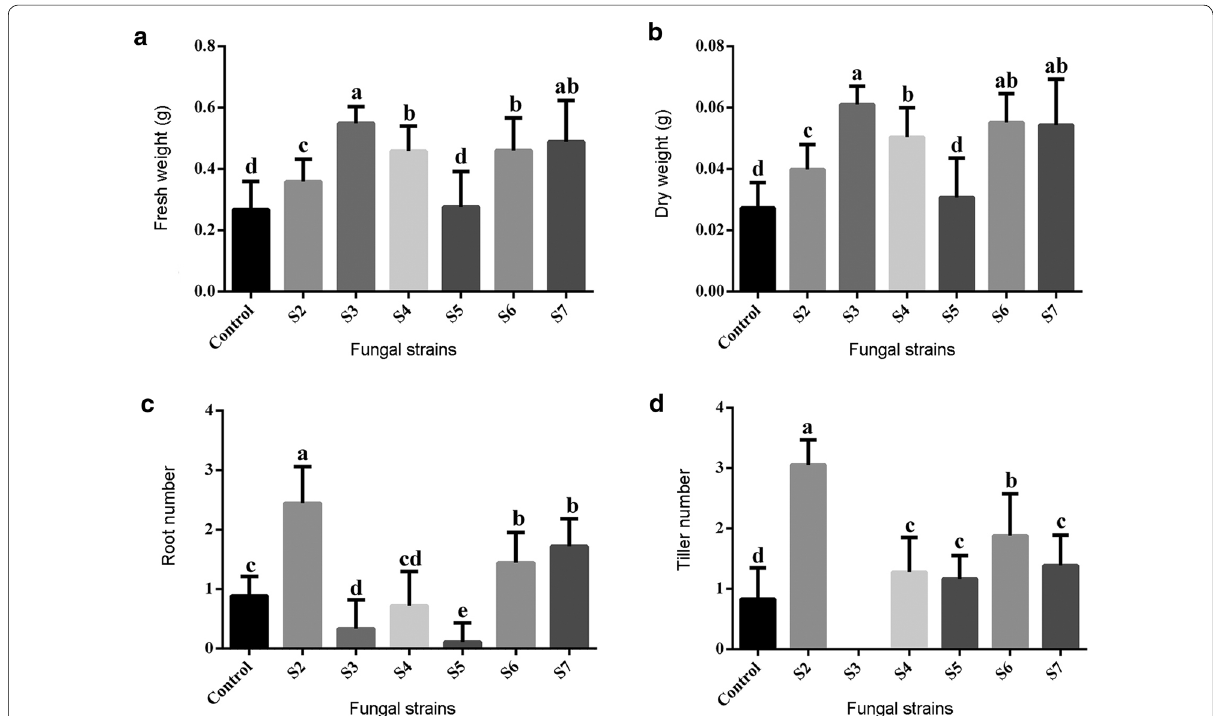
Fig. 4 Effect of fungal strains on seedling growth of D. officinale at 15 weeks after inoculation. Change in a fresh weight, b dry weight, c root number, and d tiller number. Data are mean SE. Different letters above bars are significantly different at P < 0.05 (Fisher’s protected least significant ± difference test)